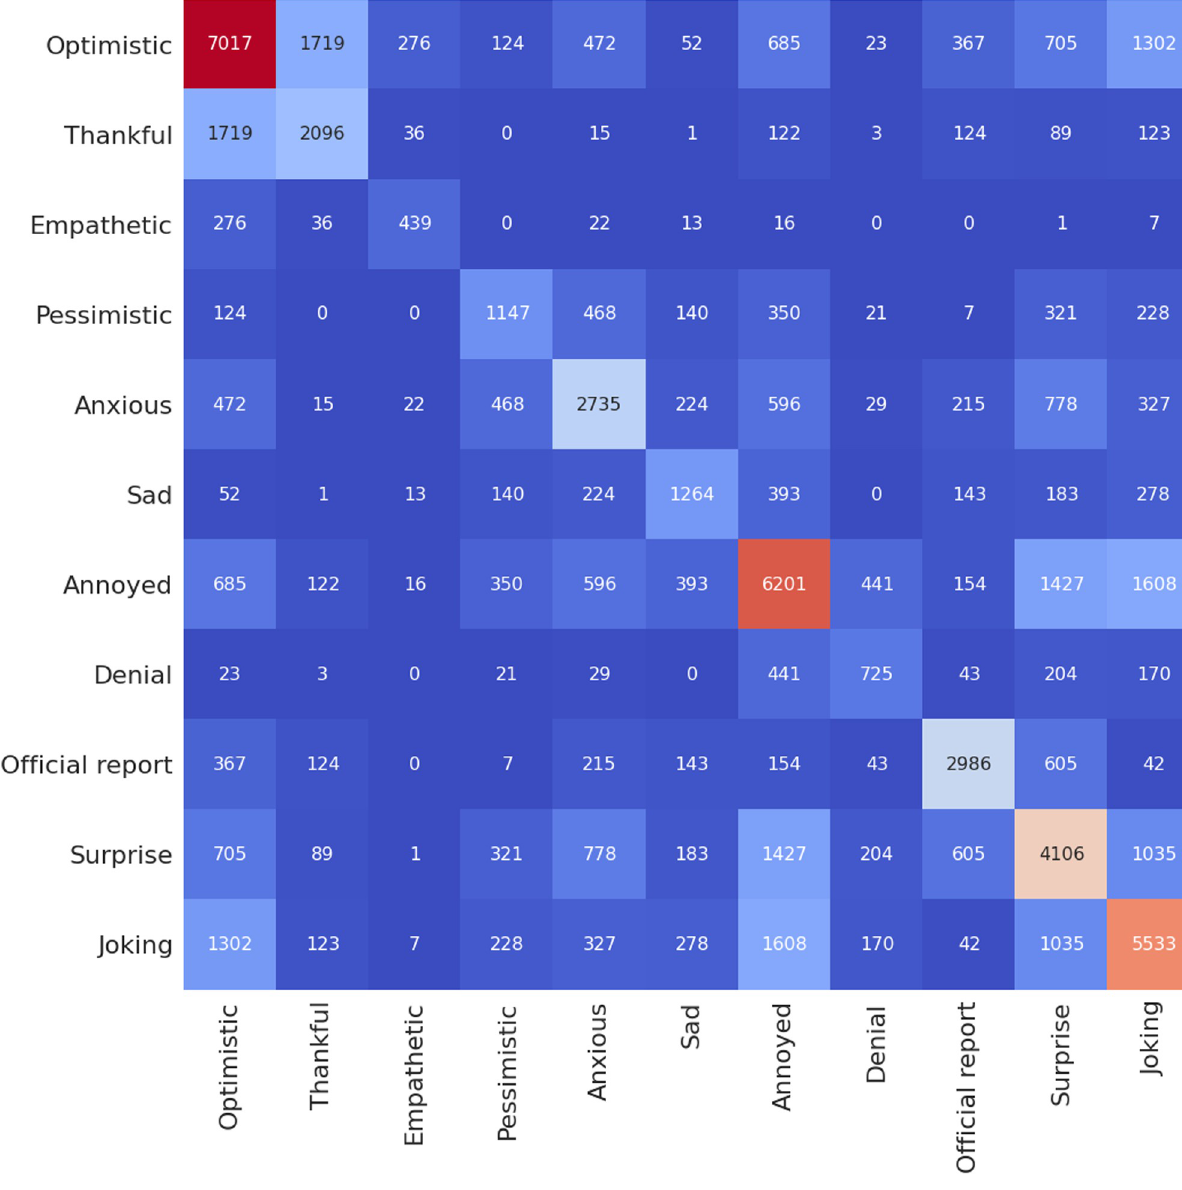
Fig 7. Heatmap showing number of occurrence of a given sentiment in relation to the rest of the sentiments for the Maharashtra dataset using the BERT model.